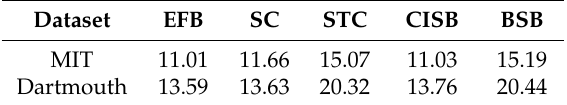
Table 7. Comparison of KL divergence values between PCMs selection methods.